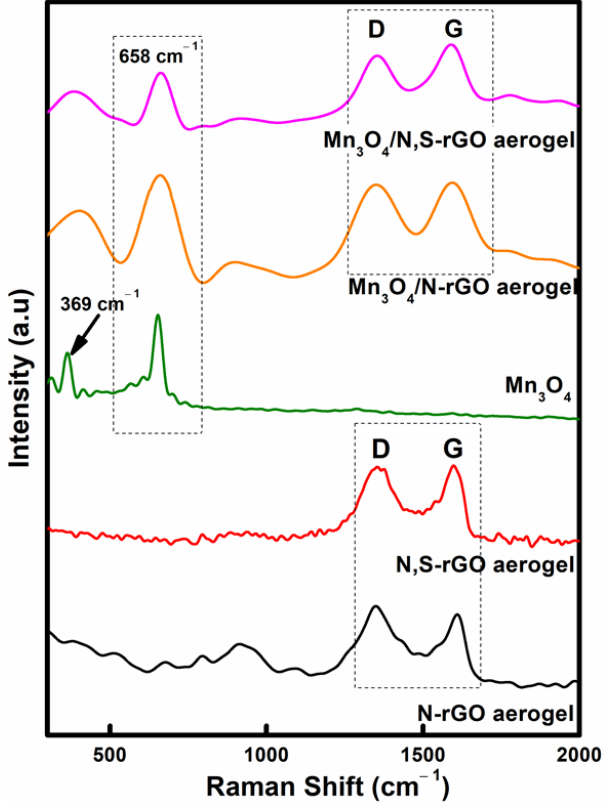
Figure 5. Raman spectra of N-rGO aerogel, N,S-rGO aerogel, Mn 3 O 4 nanoparticles, Mn 3 O 4 /N-rGO aerogel, and Mn 3 O 4 /N,S-rGO aerogel.